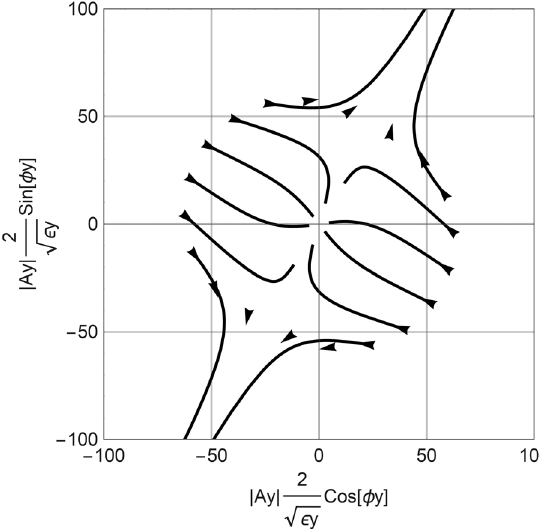
FIG. 20. Evolution of the average particle trajectories, solu- tion of Eqs. (49) and (50) with the same initial amplitude and different initial phases. Initial amplitude corresponds 0 Þ ¼ 58 σ to y 0 ð φ y ¼ y